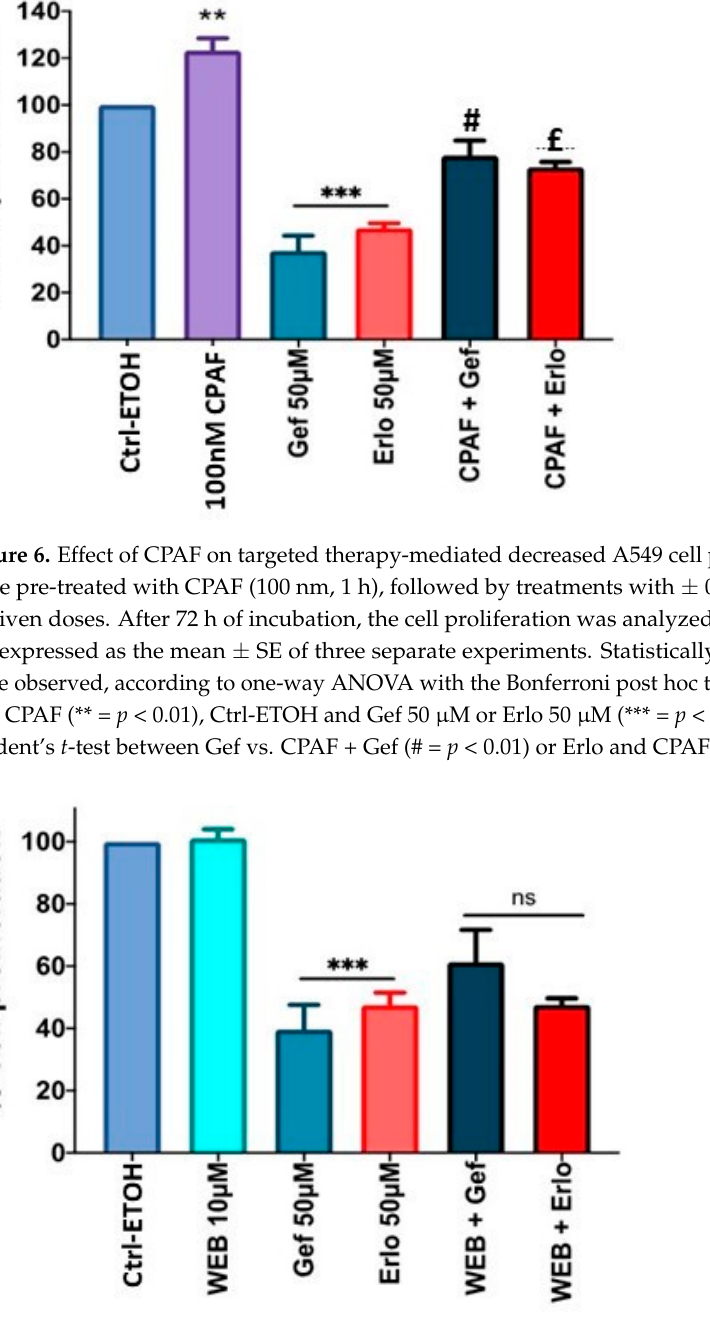
Figure 7. Effect of PAFR antagonist on targeted therapy-mediated decreased cell proliferative re- sponse. A549 cells were pretreated with a PAFR antagonist, WEB2086 (10 µM, 1 h), and then with ± Gef or Erlo (50 µM) and vehicle (0.1% ETOH). After 72 h of incubation, the cell proliferation was measured via the CV assay. Data are expressed as the mean ± SE of five separate experiments. Sta- tistically significant differences were observed, via one-way ANOVA with the Bonferroni post hoc test, between Ctrl-ETOH and Gef 50 µM or Erlo 50 µM (*** = p < 0.001). “ns” denotes a non-signifi- cant change between Gef and WEB + Gef or Erlo and WEB + Erlo.